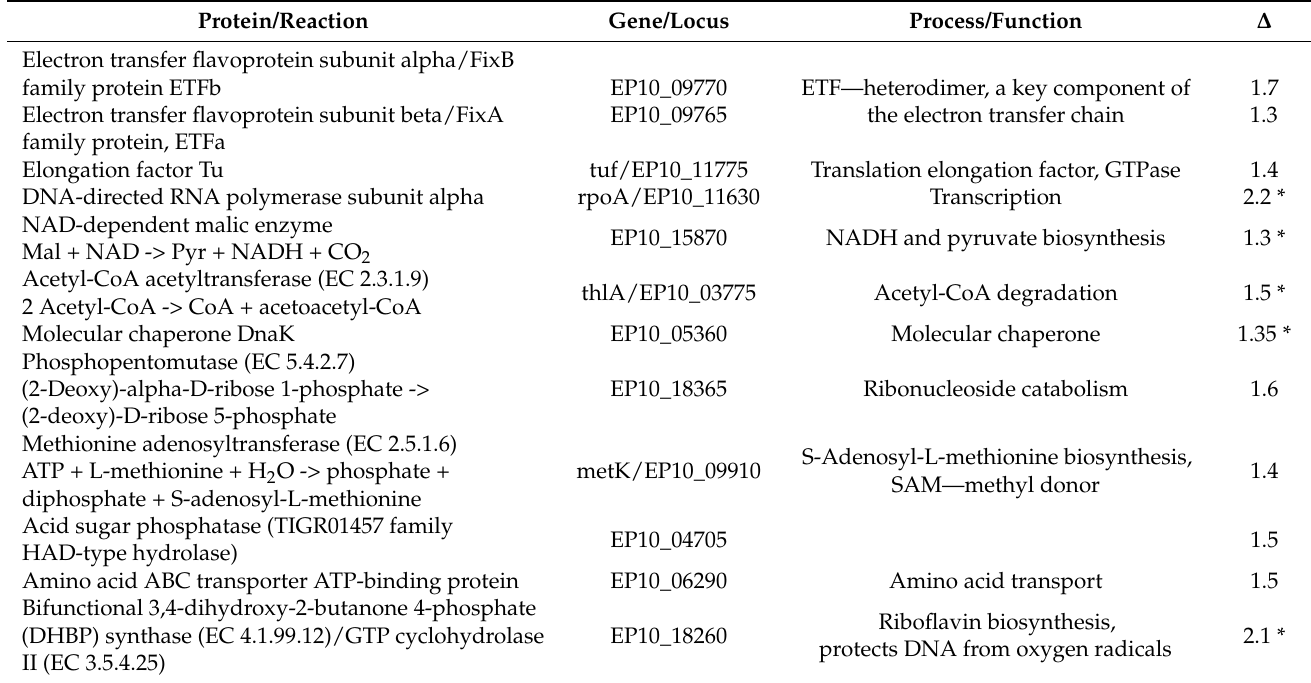
Table 3. The identified proteins significantly downregulated in the proteomic profile of G. icigianusat 10 min after the end of THz irradiation.